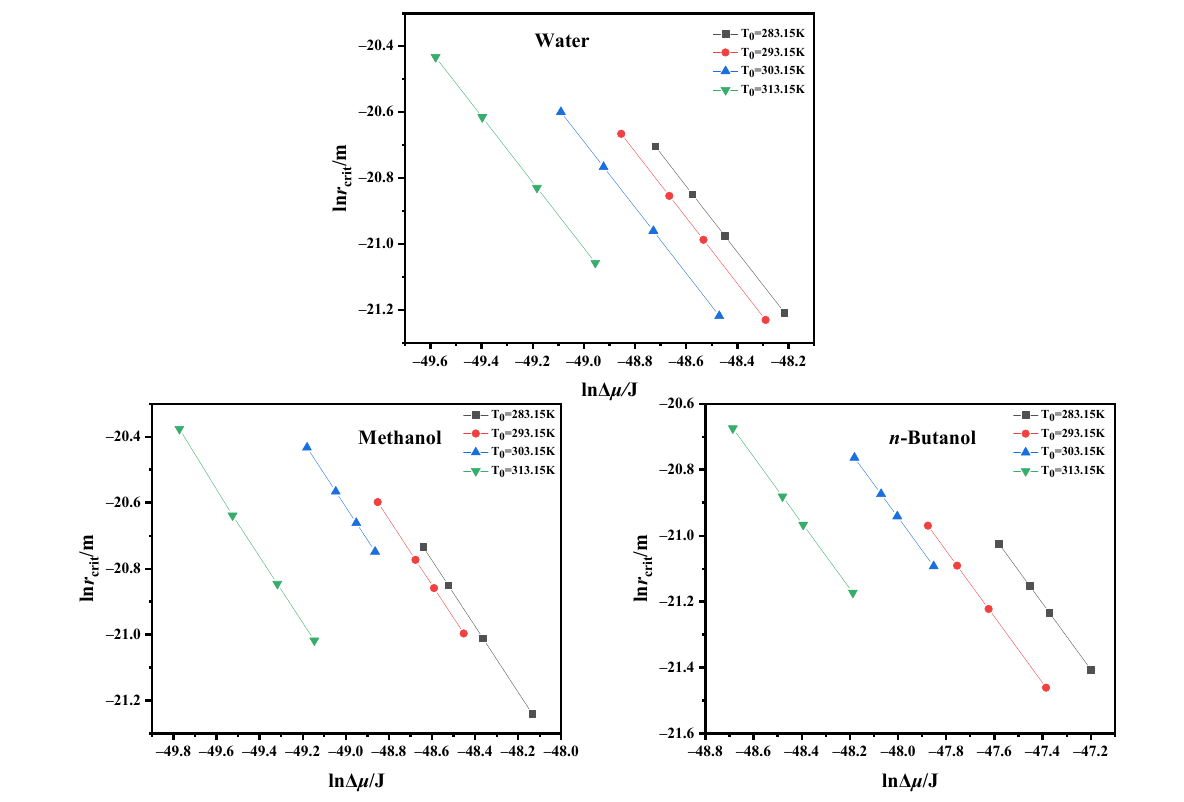
Figure 10. Relationships between driving force and critical nuclei size.